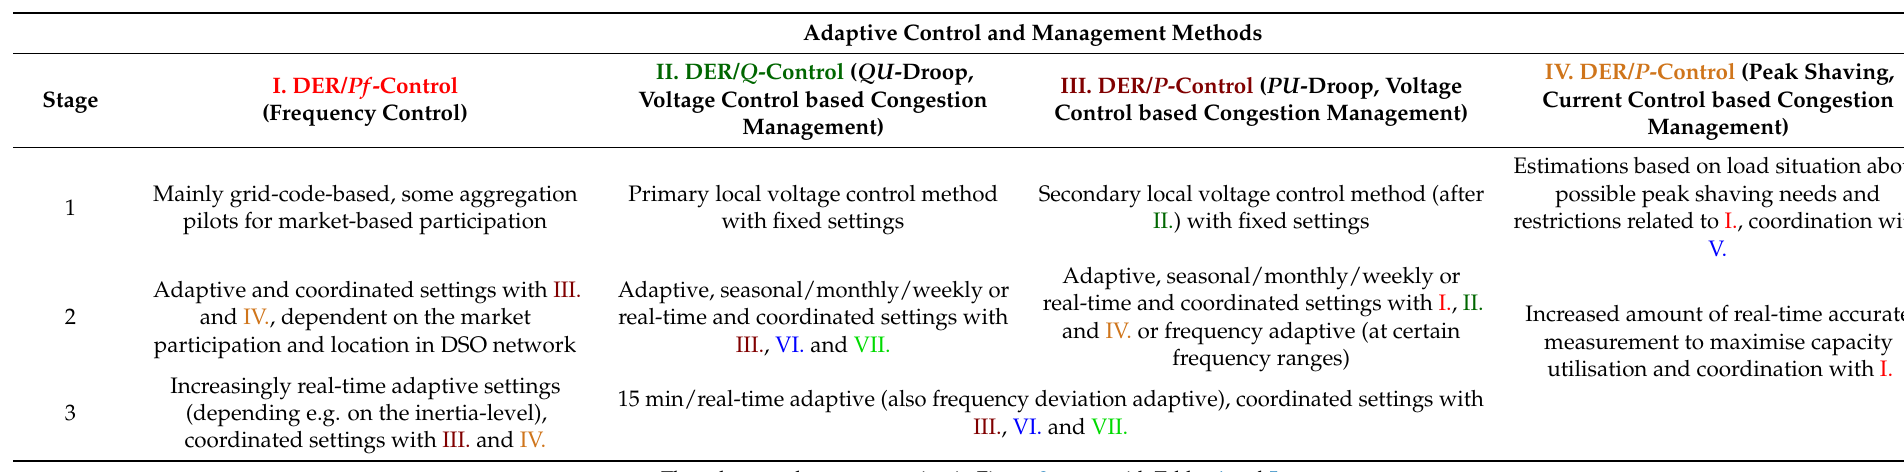
Table 3. Adaptive control and management methods I.–IV. evolution during different stages 1–3 (see Figure 3, Tables 4 and 5).